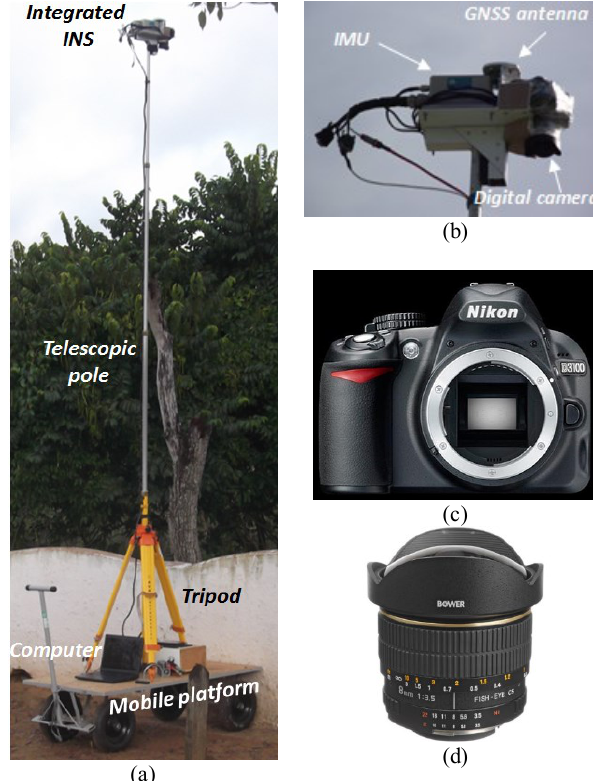
Figure 3. (a) The acquisition unit; (b) details of camera and INS (c) the Nikon D3100 digital camera and; (d) Bower fisheye